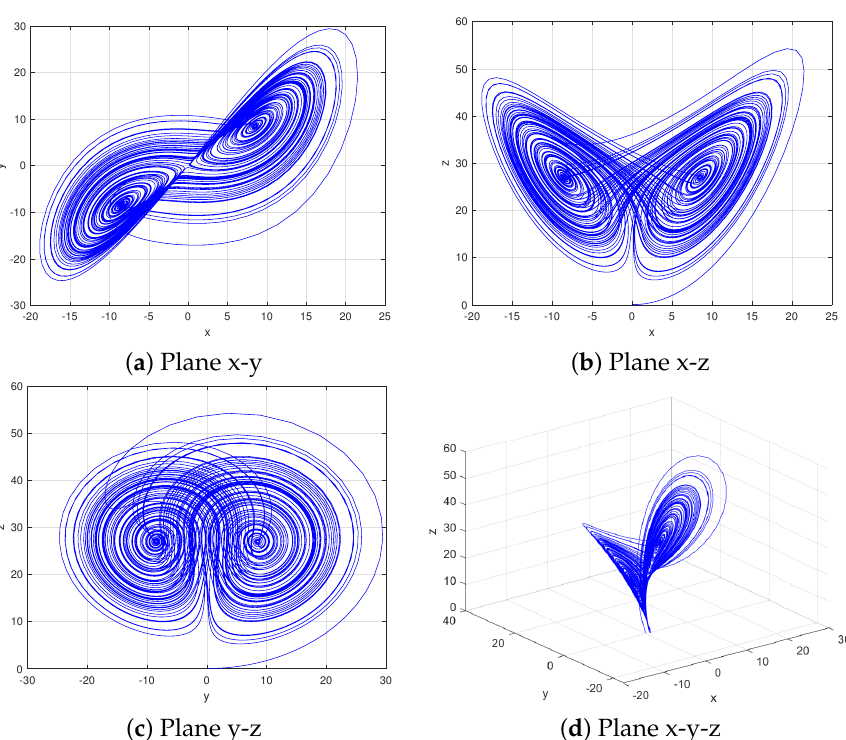
Figure 1. Phase-space portraits of the Lorenz chaotic system given in (1).